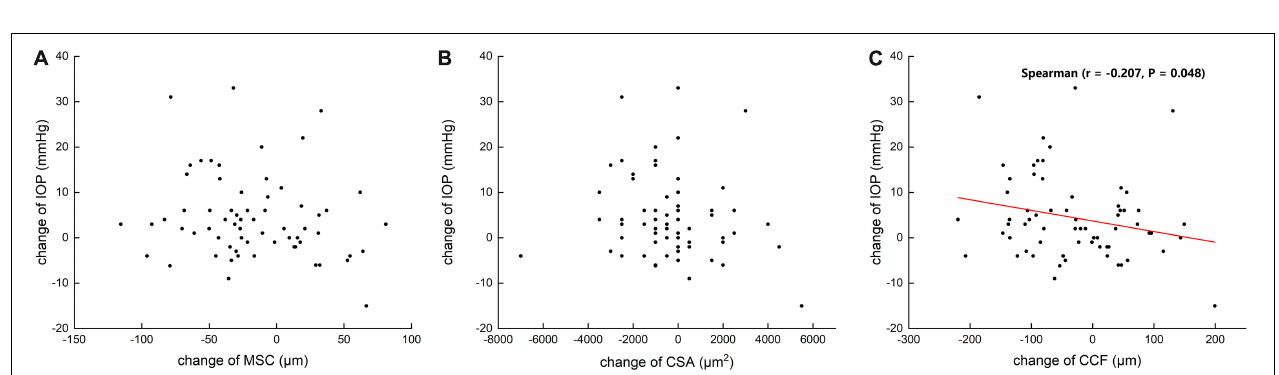
FIGURE 5 | Scattergrams showing the correlations between the changes in preoperative and postoperative intraocular pressure (IOP) and the changes in the meridional diameter of Schlemm’s canal (MSC) (A) and cross-sectional area (CSA) (B) and circumference (CCF) (C) in all subjects.